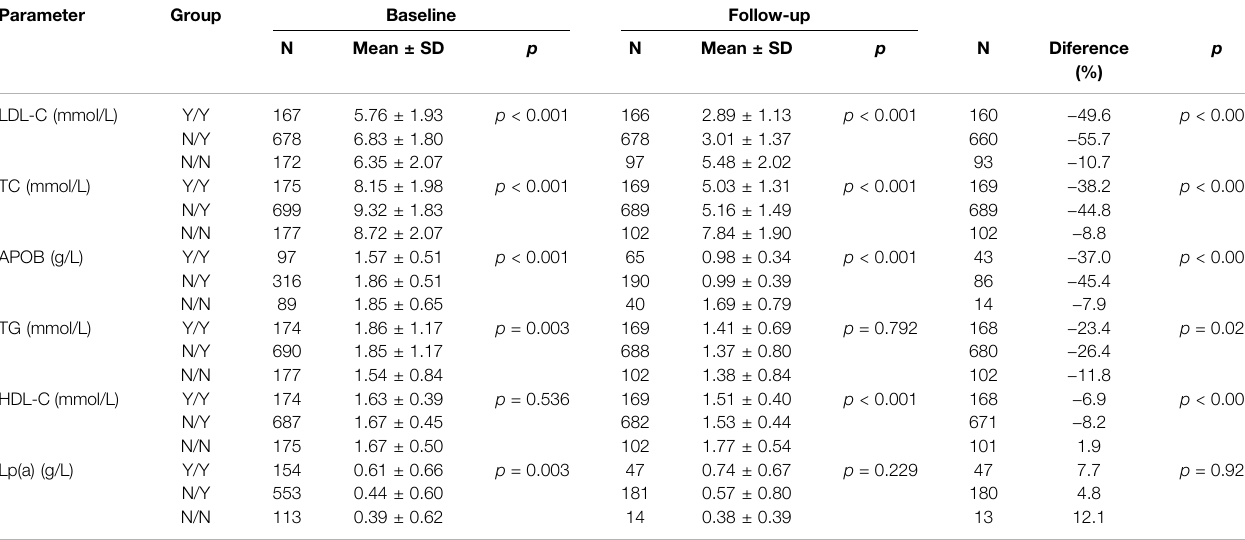
Table 3 | Distribution of FH patients by treatment and effect of treatment on lipid levels. Parameter Group Baseline